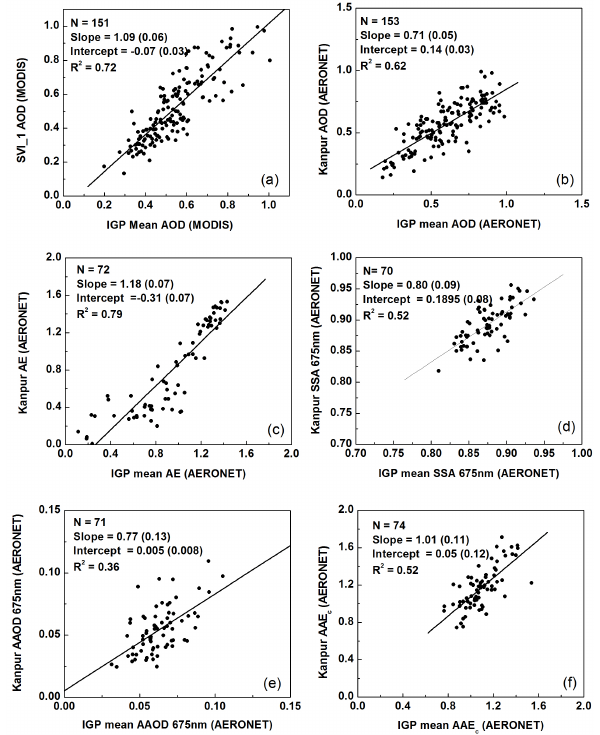
Fig. 13. Comparison of daily mean IGP MODIS and IGP AERONET to local (Kanpur and SVI 1) scale aerosol op- tical properties for the period November 2009 to May 2010. IGP AERONET was calculated from the mean of six AERONET sites located in India and Nepal (see Fig. 1). The IGP MODIS rep- resents the mean of the AOD over the region shown as dashed line in Fig. 1. Standard errors for slope and Y offset at 95% confidence are given in